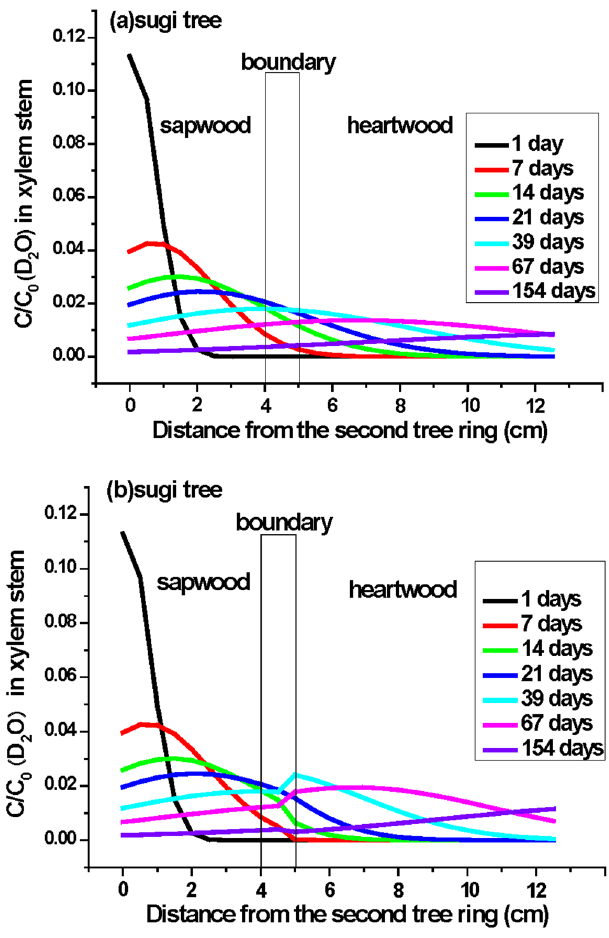
Figure 5. Distribution of the D 2 O concentration ratio (C/C 0 ) in the xylem stem of a sugi tree estimated by using the simple one-dimensional advective diffusion transport model 37 . ( a ) Constant magnitude of diffusion coefficients of D 2 O [0.24 cm 2 day −1 (= 2.8 × 10 –10 m 2 s −1 )] in all xylem stem, and ( b ) magnitude of diffusion coefficients changed in the intermediate wood zone (change from 0.24 cm 2 day −1 to 0.123 cm 2 day −1 (= 1.42 × 10 –10 m 2 s −1 ) after 4.5 cm). Note: The D 2 O migration velocity is 0.1 cm day −1 in xylem stems. x = 0 is